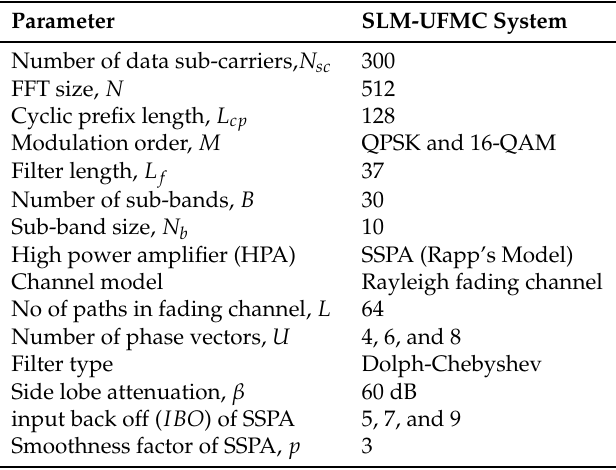
Table 1. The SLM-UFMC system parameters.